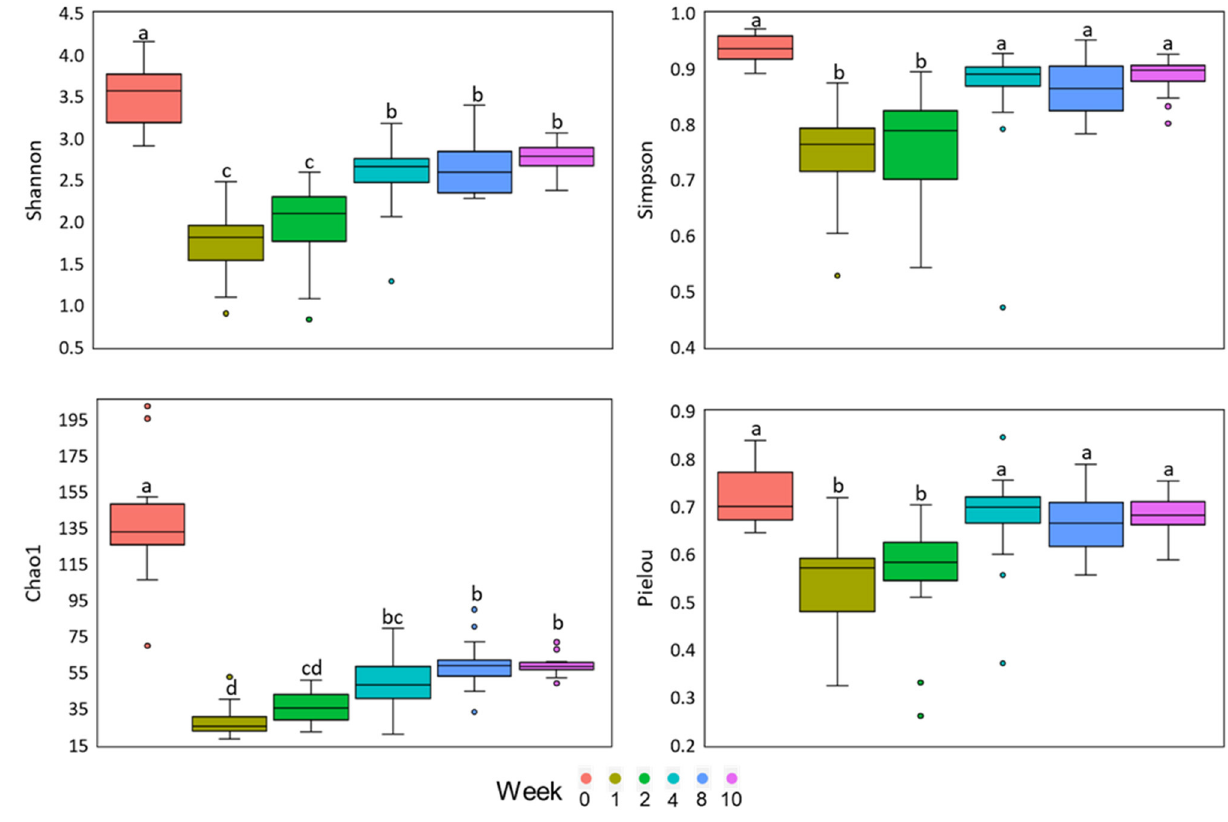
FIGURE 3 | α -diversity indices in fecal samples from dairy calves fed different liquid diets. Data are visualized as box-plots showing the median and the interquartile (midspread) range (boxes containing 50% of all values), the whiskers (representing the 25 and 75 percentiles) and the extreme data points. Letters above boxes indicate significant differences at P >